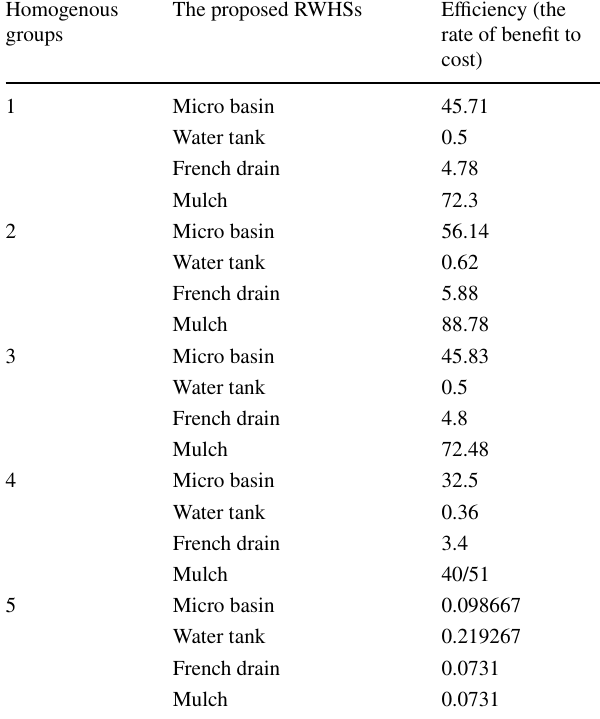
Table 6 The efficiency of the proposed RWHSs Homogenous groups